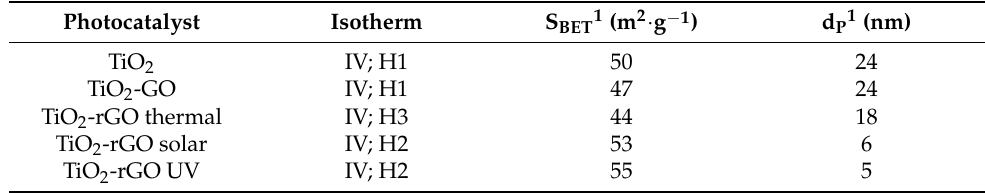
Table 1. Textural properties of the examined